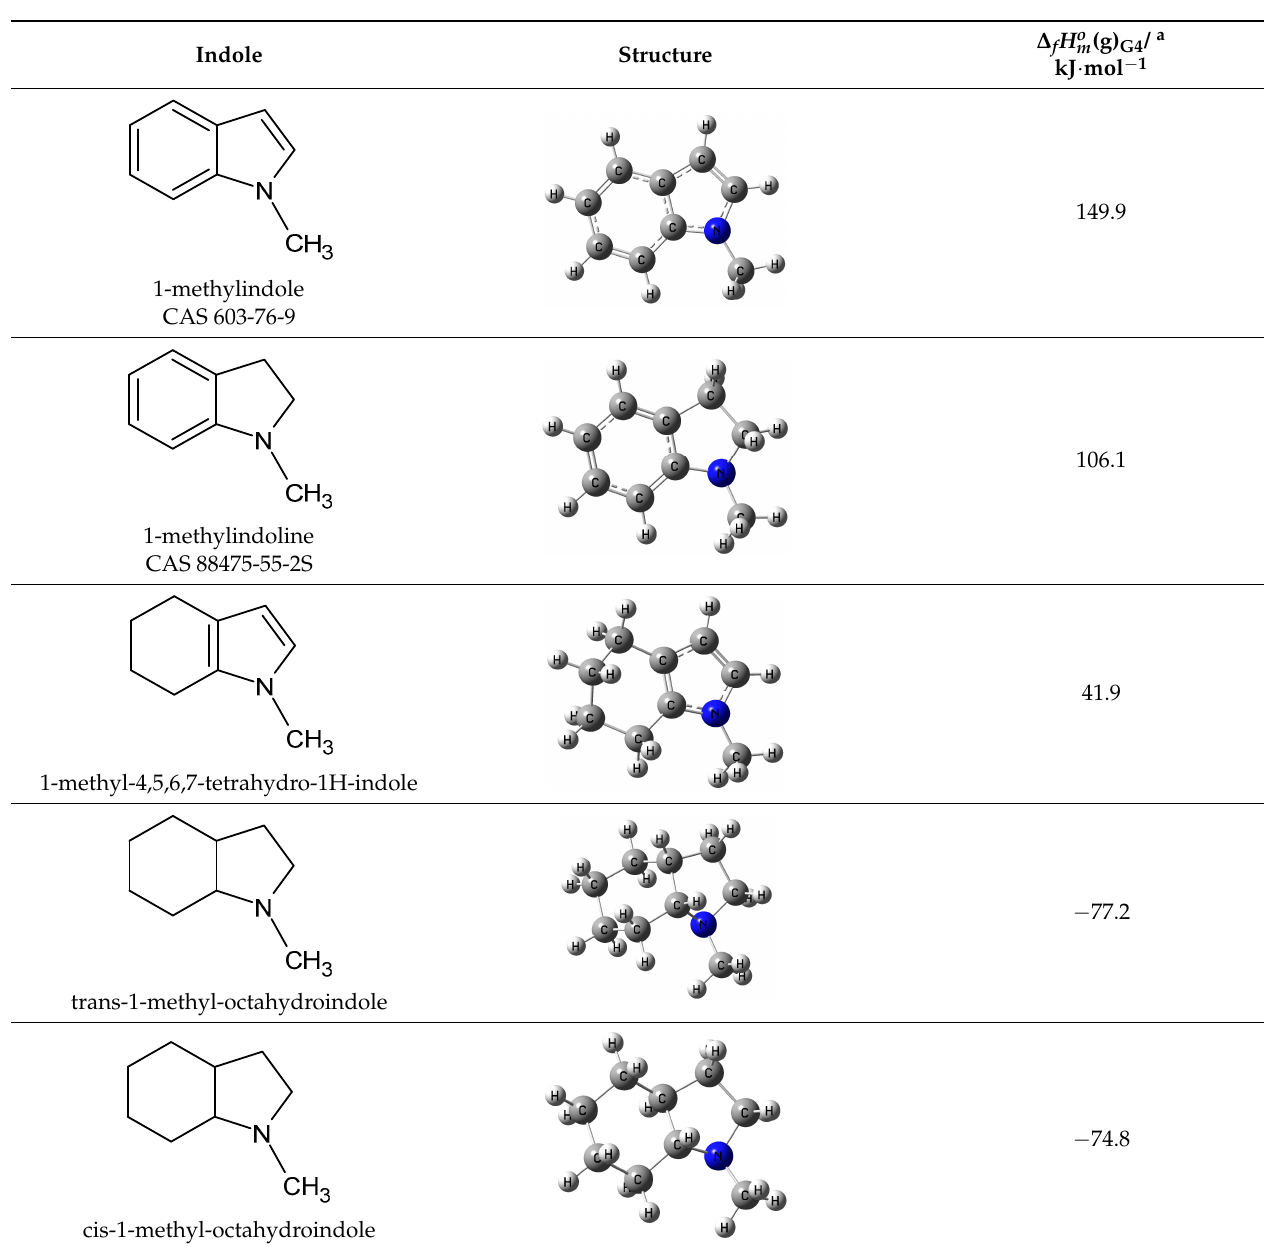
Table 5. Most stable conformers (G4 calculations) of reaction intermediates of R-I to R-IV and their gas phase formation enthalpies.